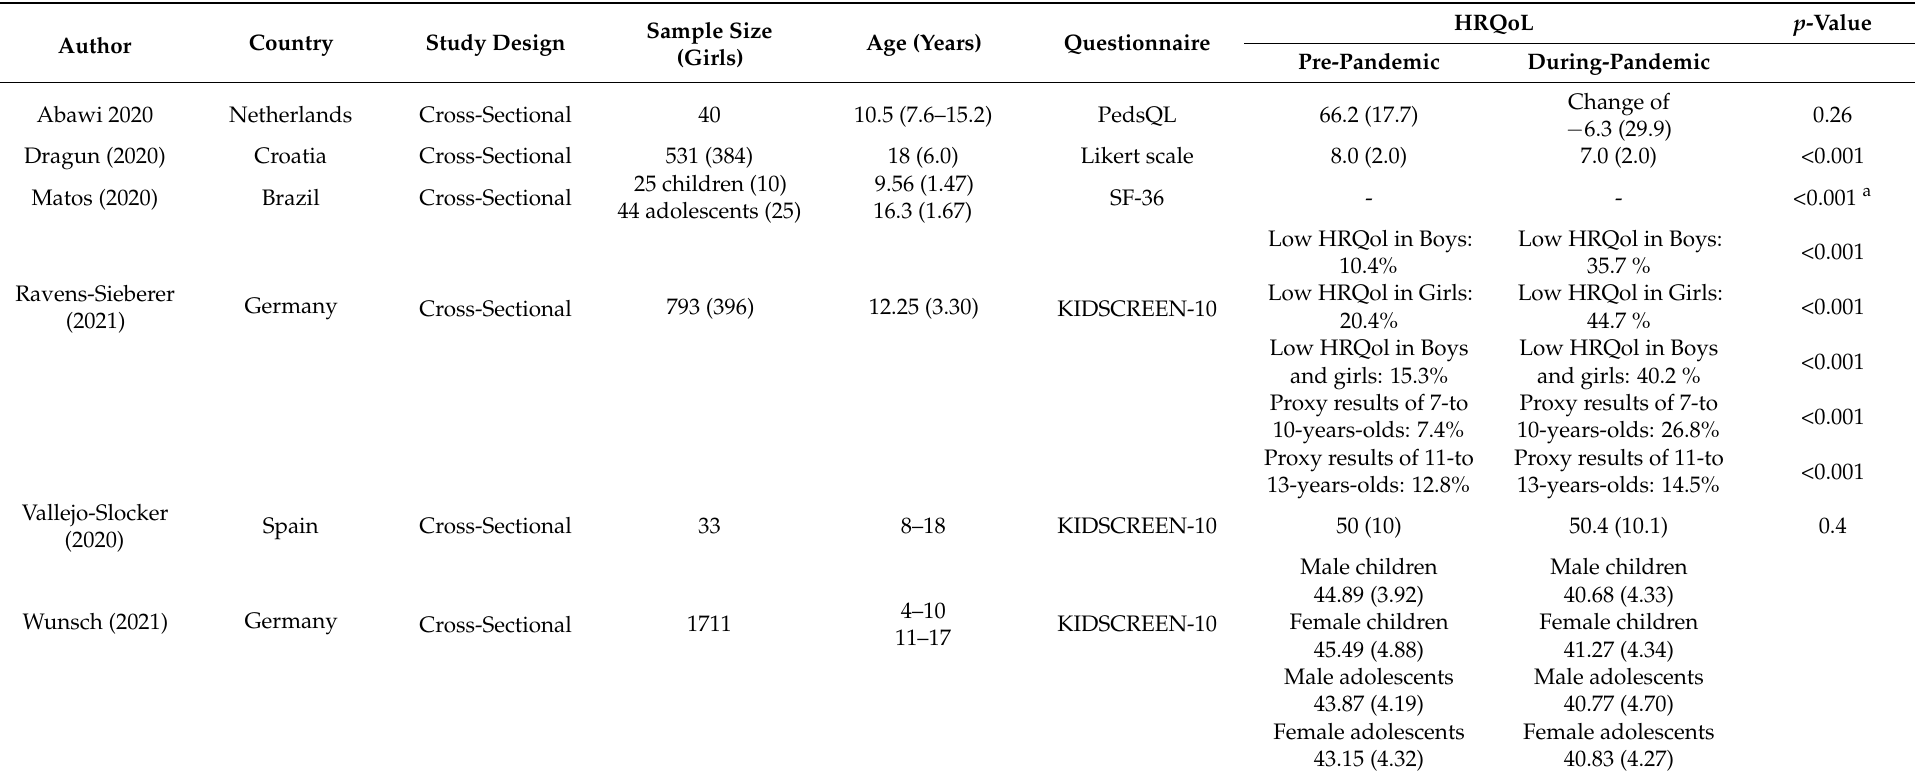
Table 2. Main findings of children and/or adolescents HRQoL pre- and during COVID-19